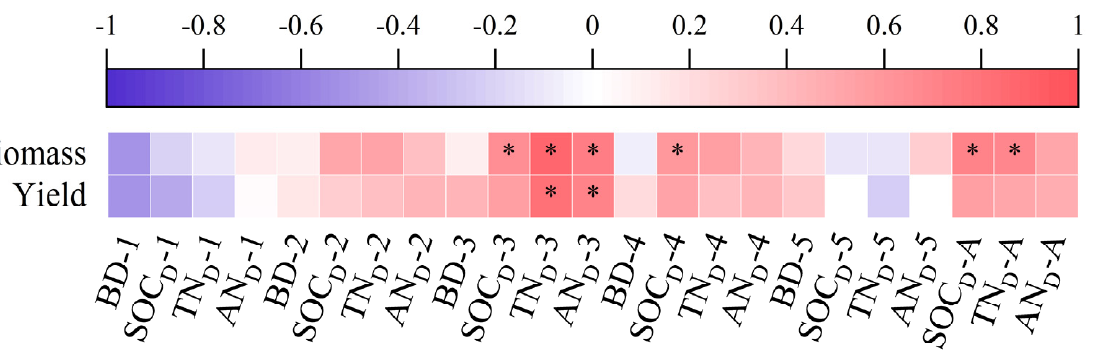
Table S1: Rice biomass and grain yield in the last four years under rotations; Table S3: Percentage share of total soil C and N content in investigated layers in ratio total stock in 0–50 cm (%); Table S4: The stratification ratios of SOC, TN, and AN densities.